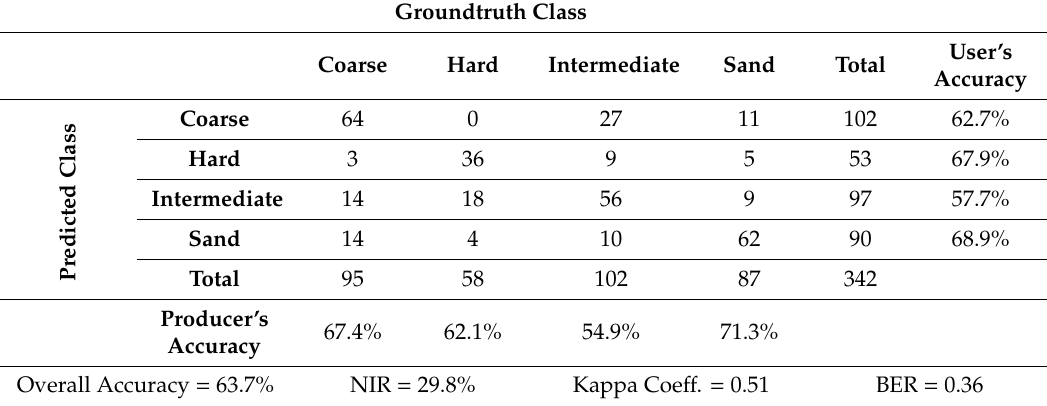
Figure 10. Per class agreement (mean value between user’s and producer’s accuracy) for each habitat class and the three classification models, comparing the 2015 Day 1 and 2015 Day 2 classifications.